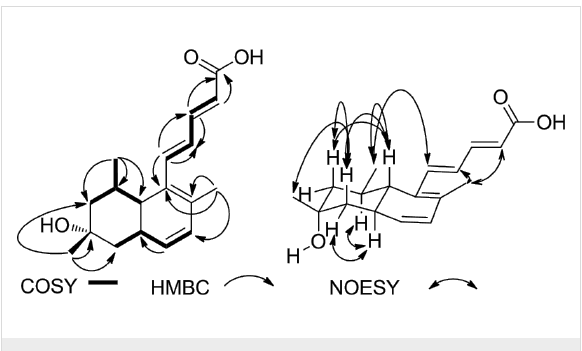
Figure 4: HMBC, COSY and NOESY correlations of compound 4